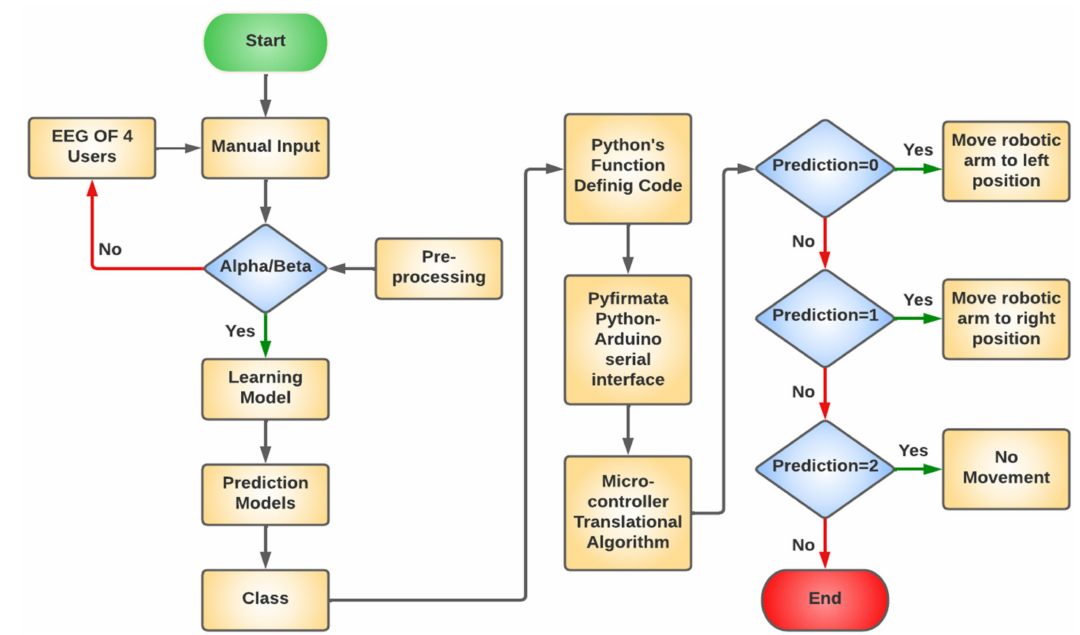
Figure 4. Flow chart of the system.